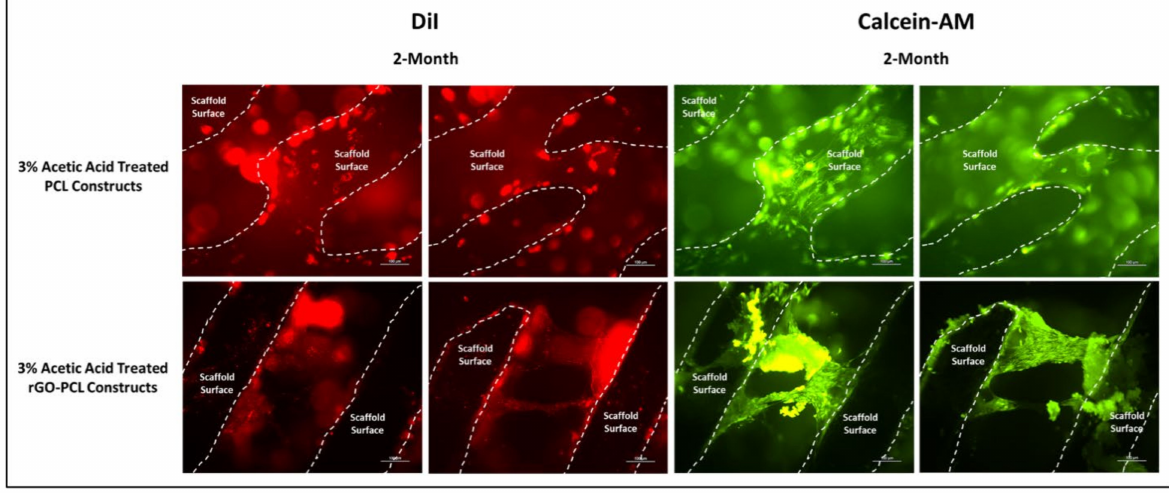
Figure 8. rDPSCs cultured for 2 months on PCL and rGO-PCL constructs etched with 3% acetic acid, under fluorescent imaging at 10 × magnification. DiI-labeled and Calcein-AM-stained cells are shown with scaffold surfaces highlighted via dashed